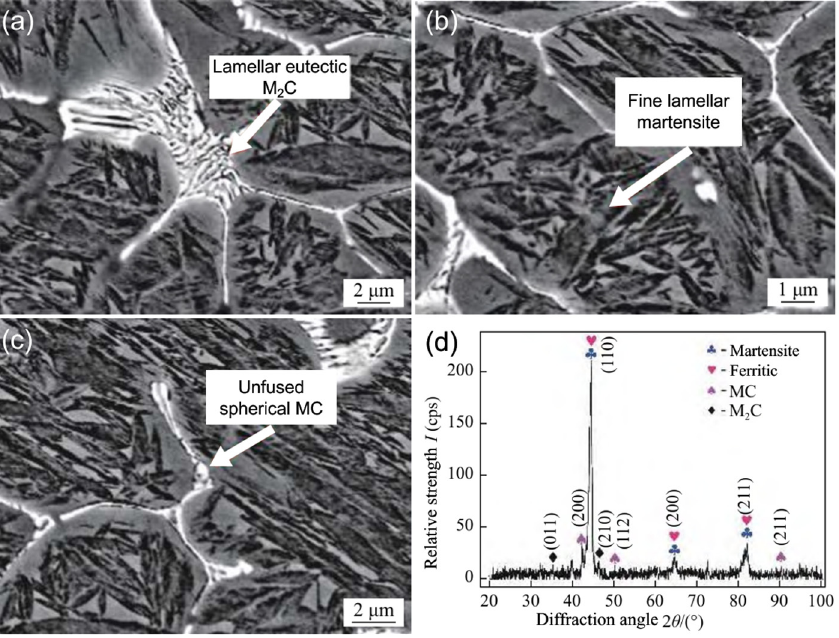
Figure 2. SEM image of W6 HSS ( a ) Lamellar M 2 C eutectic carbide; ( b ) Fine flake martensite; ( c ) Unfused spherical MC carbide; ( d ) XRD results